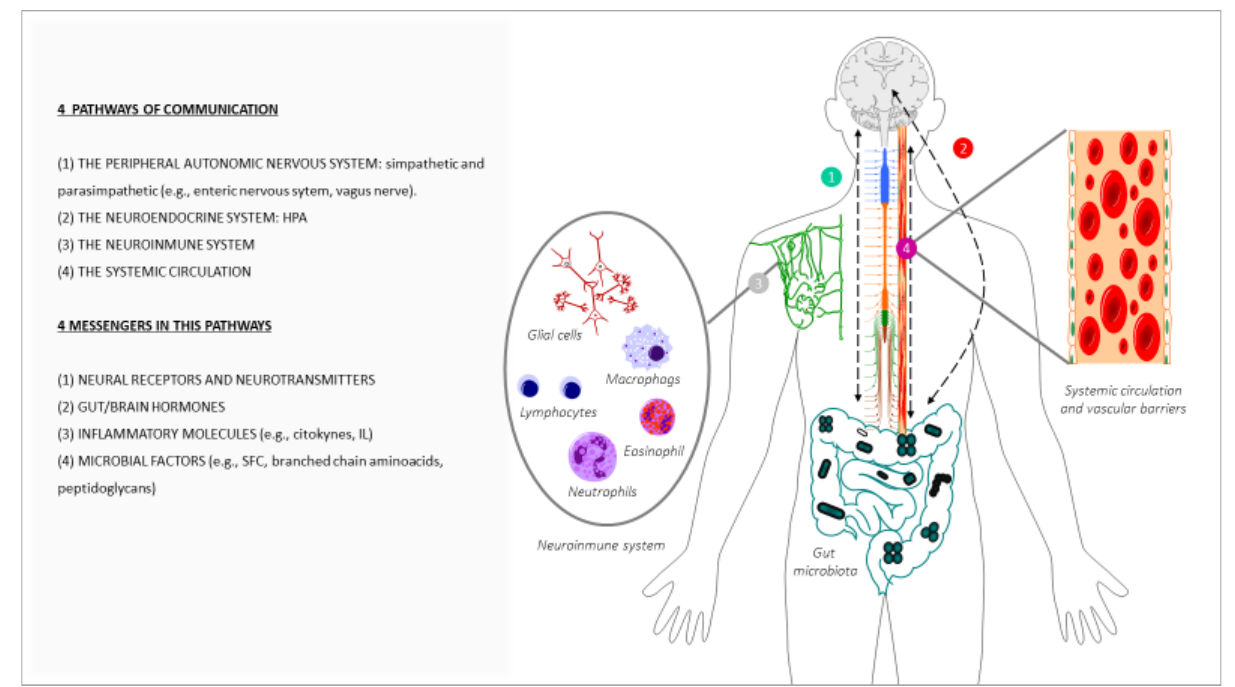
Figure 1. Main messengers and pathways of communication involved in the crosstalk between the gut and the brain.